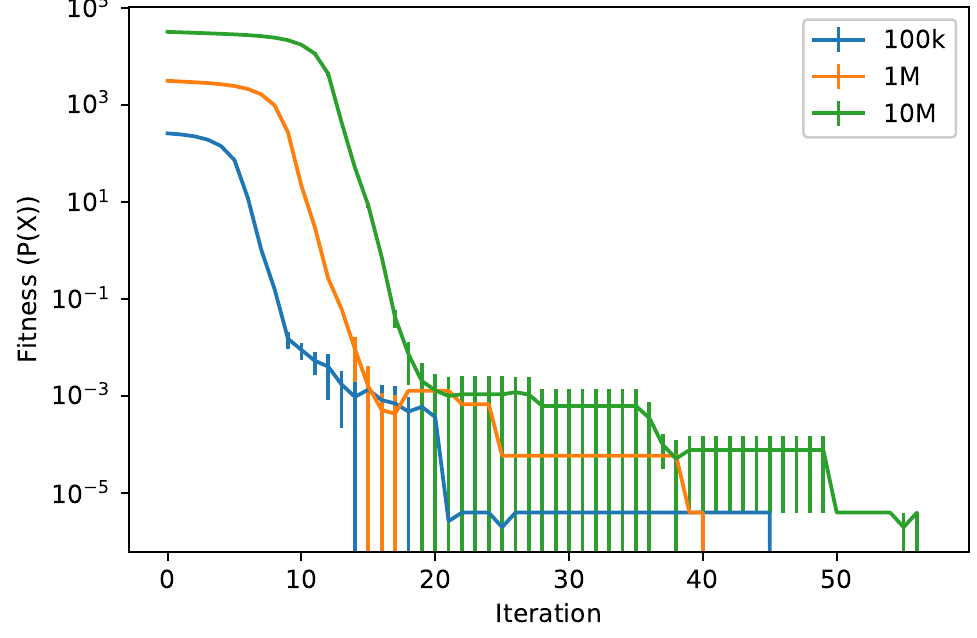
Figure 4. Best fitness value per iteration (mean ± std. dev. across 10 runs) on the casting scheduling problem in three different